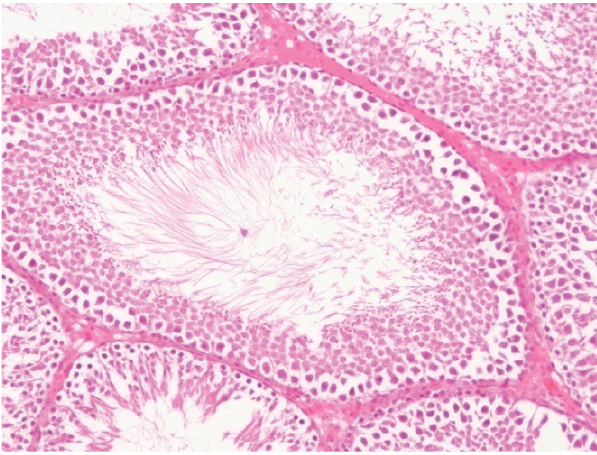
Figure 3 - Photomicrograph of the marked regenerative effect of protective treatment with vitamin C showing normal seminifer- ous tubules, spermatocytes and spermatids. H&E 6 100.